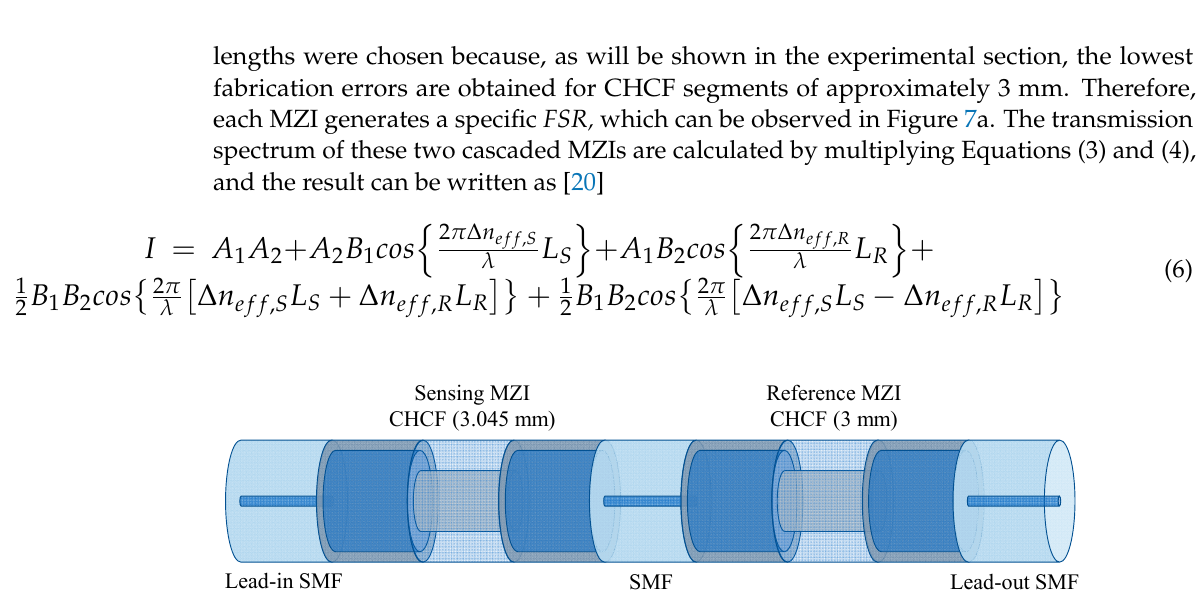
Figure 6. Schematic drawing of two cascaded MZI with different lengths.